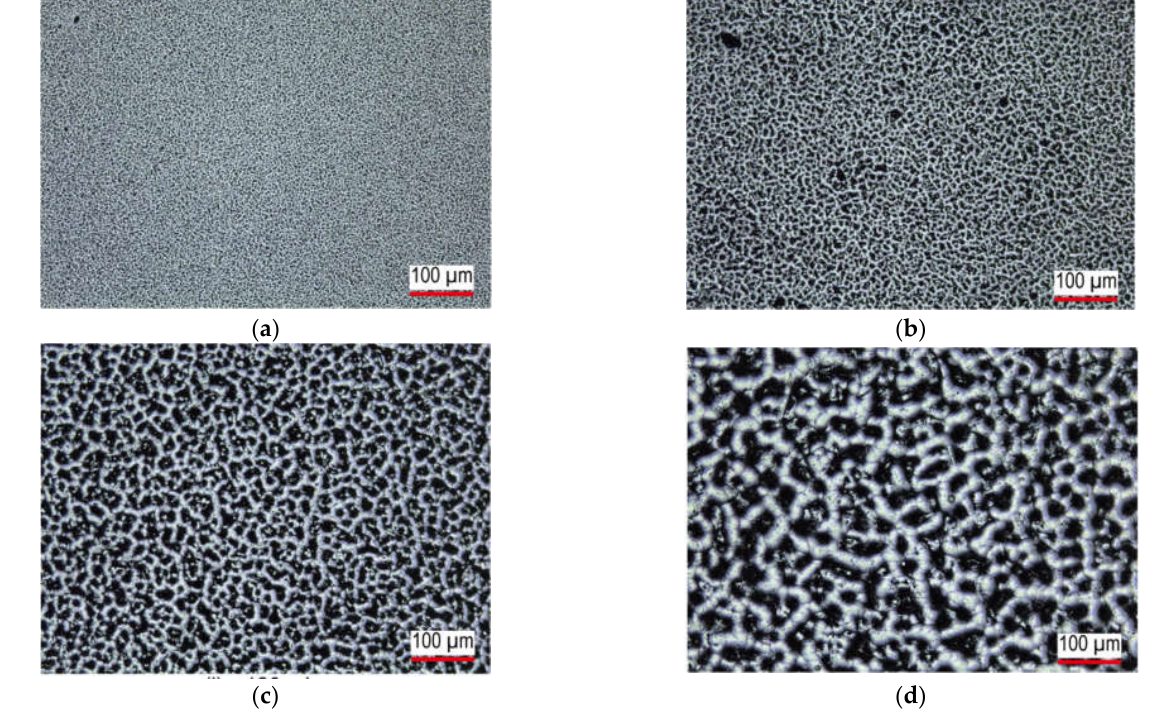
Figure 2. Tactile samples with random patterns for dry perception experiment. Samples treated with dry etching for ( a ) 30, ( b ) 60, ( c ) 120, and ( d ) 240 min.